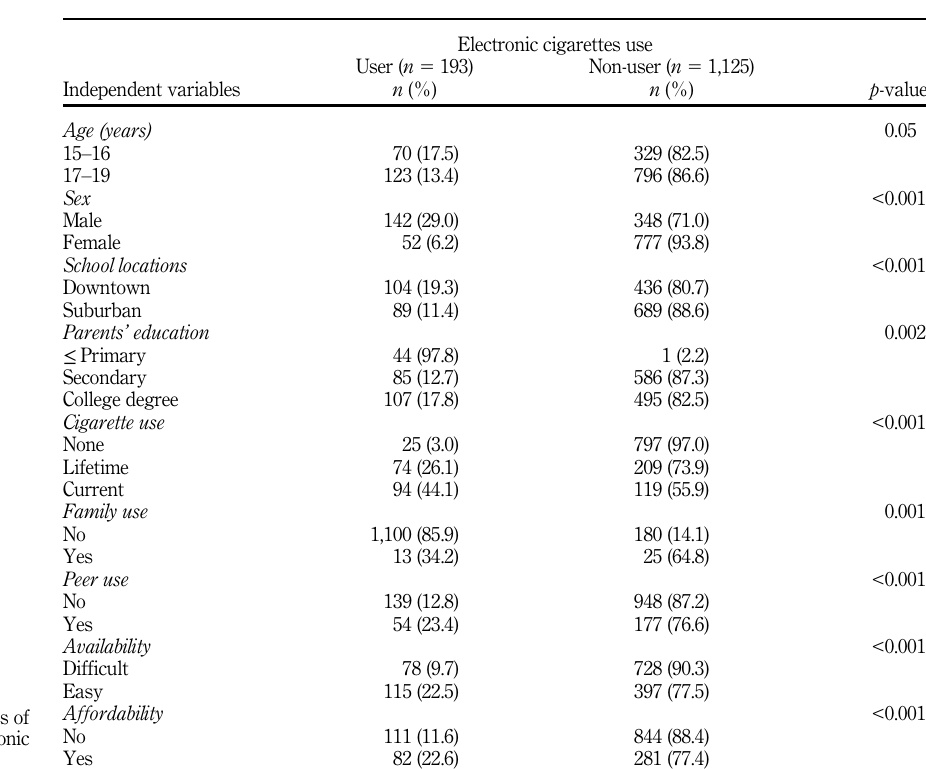
Table 3. Bivariate analysis